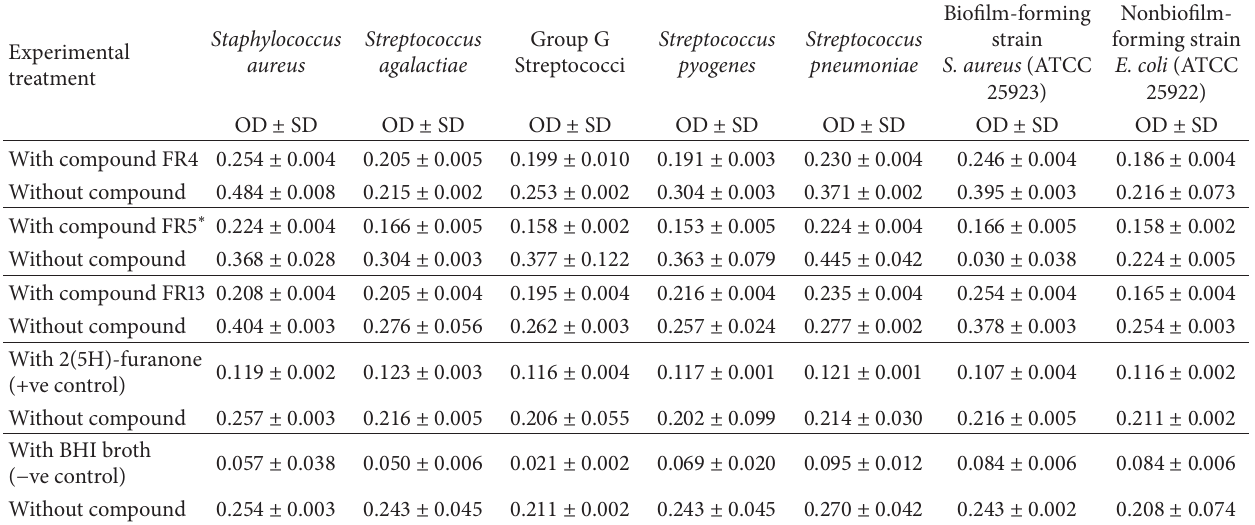
Table 2: Antibiofilm activity of potential compounds of 139SI against Gram-positive clinical